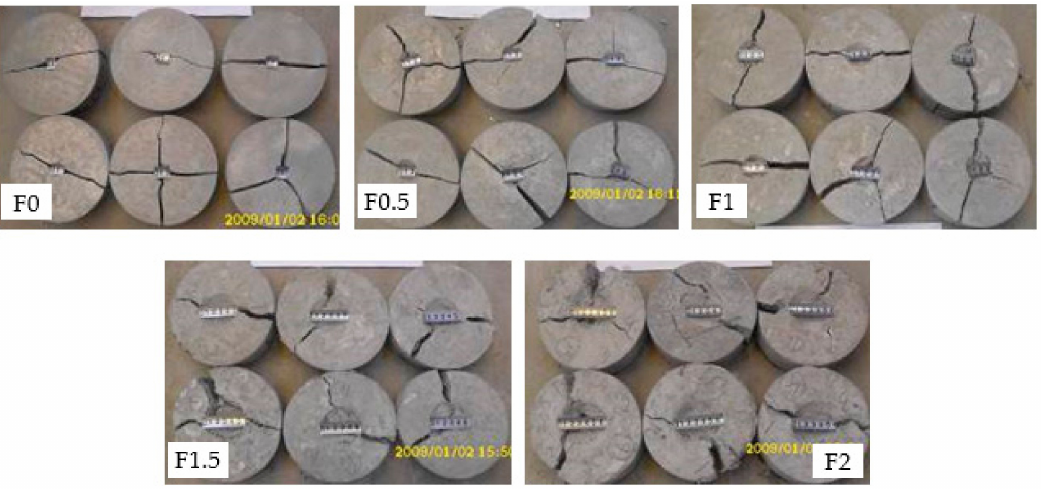
Figure 3. Failure patterns of PVA-FRCM disc specimens.